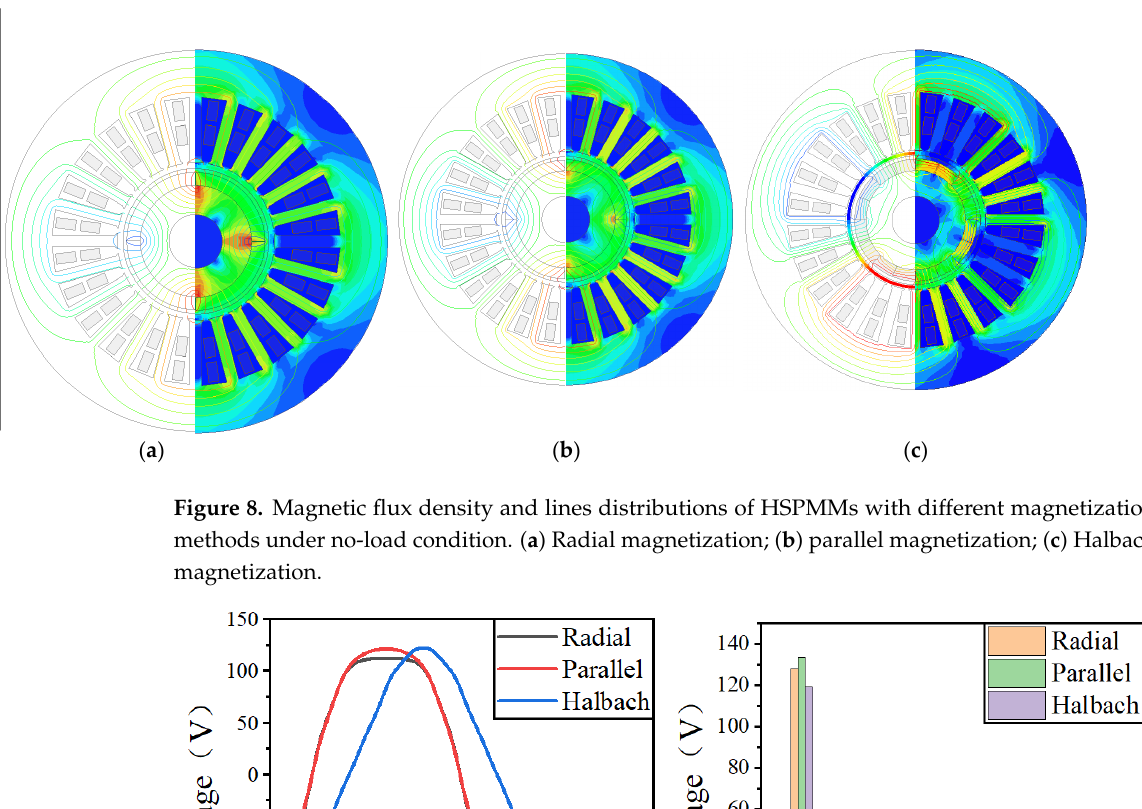
( b ) Figure 10. Waveforms and FFT analysis results of air gap magnetic flux density for HSPMMs with different magnetization methods. ( a ) Waveforms; ( b ) FFT analysis results. The three HSPMMs’ performances under full − load conditions are presented in Table 5. It can be learned that the HSPMM with PM parallel magnetized has the lowest current, the lowest torque ripple, the lowest rotor eddy current loss, and the highest efficiency. Table 5. Performances of the three HSPMMs with different PM magnetization methods under full − load condition. Parameters Radial Parallel